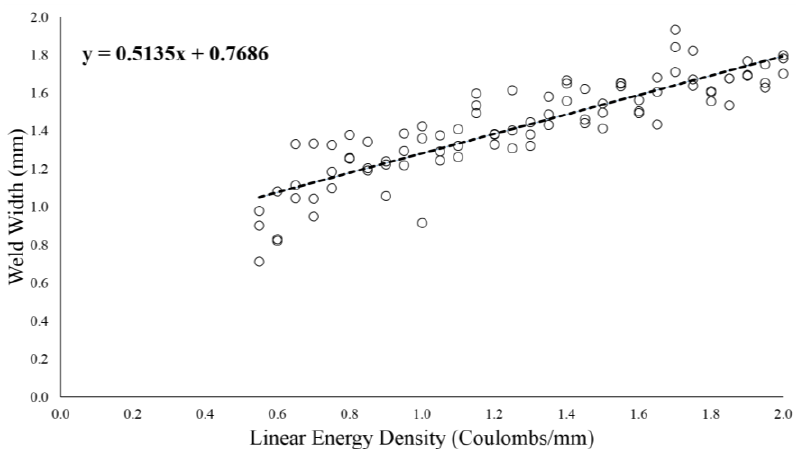
Figure 6. Weld width as a function of linear energy density for 10 mm/s on three layers of LLDPE.